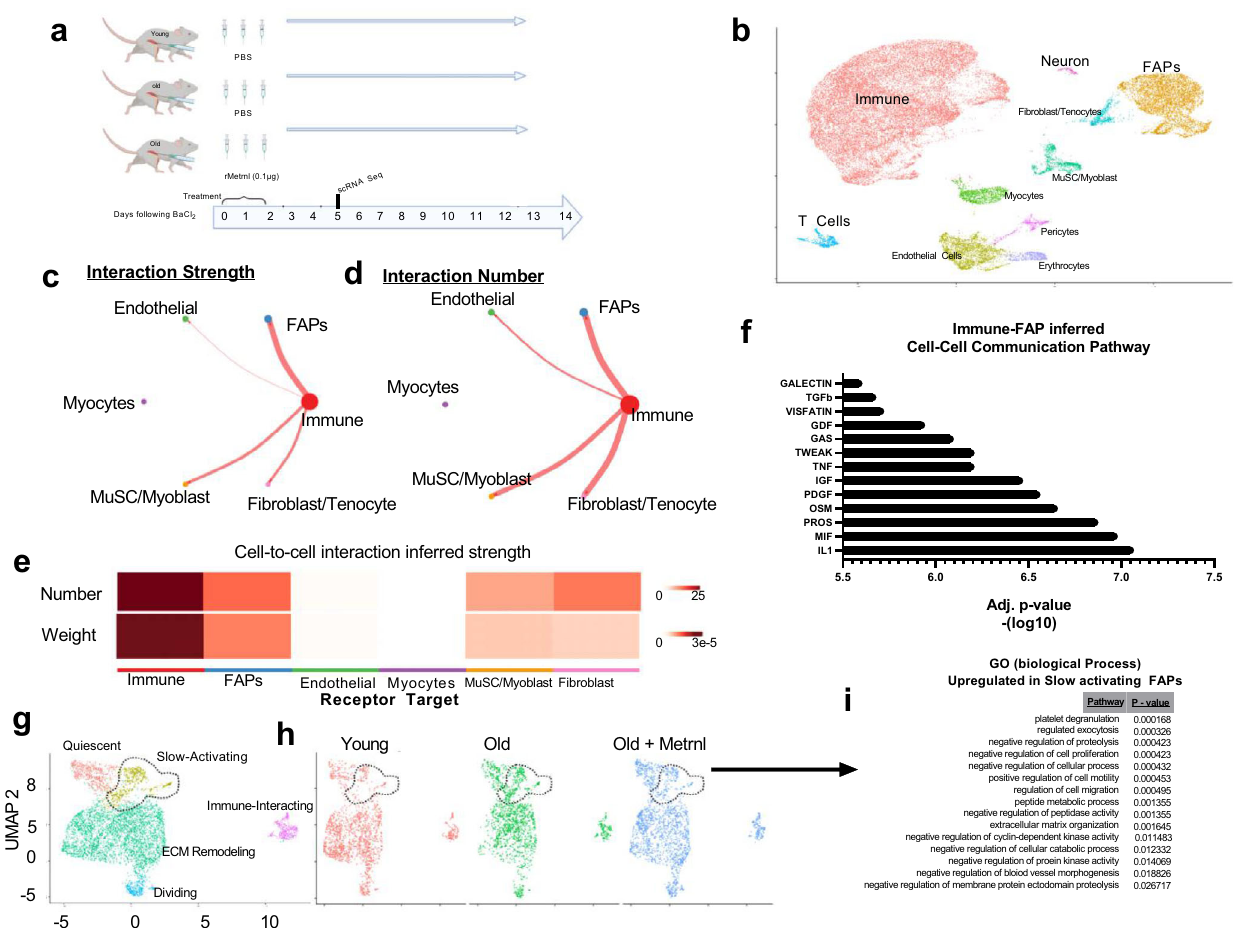
Fig.5|Single-celltranscriptomicsshowsrejuvenationofagedmuscletissueby rMetrnl treatment 4 days post-injury. a Graphical representation of the experi- mental design. b Combined UMAP reduction plotted in two dimensions with cell clusteridentitieslabeled. c , d Cell-to-cellcommunicationanalysisassessingligand/ receptorpairingsacrosscelltypes.Immunecellswerechosenforligandsourceand strength of interaction and the number of ligand/receptor pairs is indicated by chord thickness. Number of cells in a group is indicated by circle diameter. e Heatmap showing results from c , d . f Two-tailed t test was performed and FDR adjusted to infer cell-to-cell communication pathways upregulated with immune